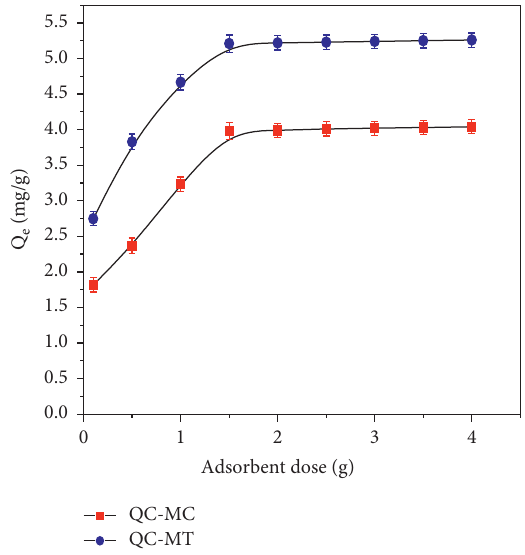
Figure 4: Effect of adsorbent mass of removal of Cd (II) ions ( V � 100mL, T � 25 ° C, C 0 � 10mg/L, contact time � 45min for QC- MC and 30min for QC-MT, and pH �